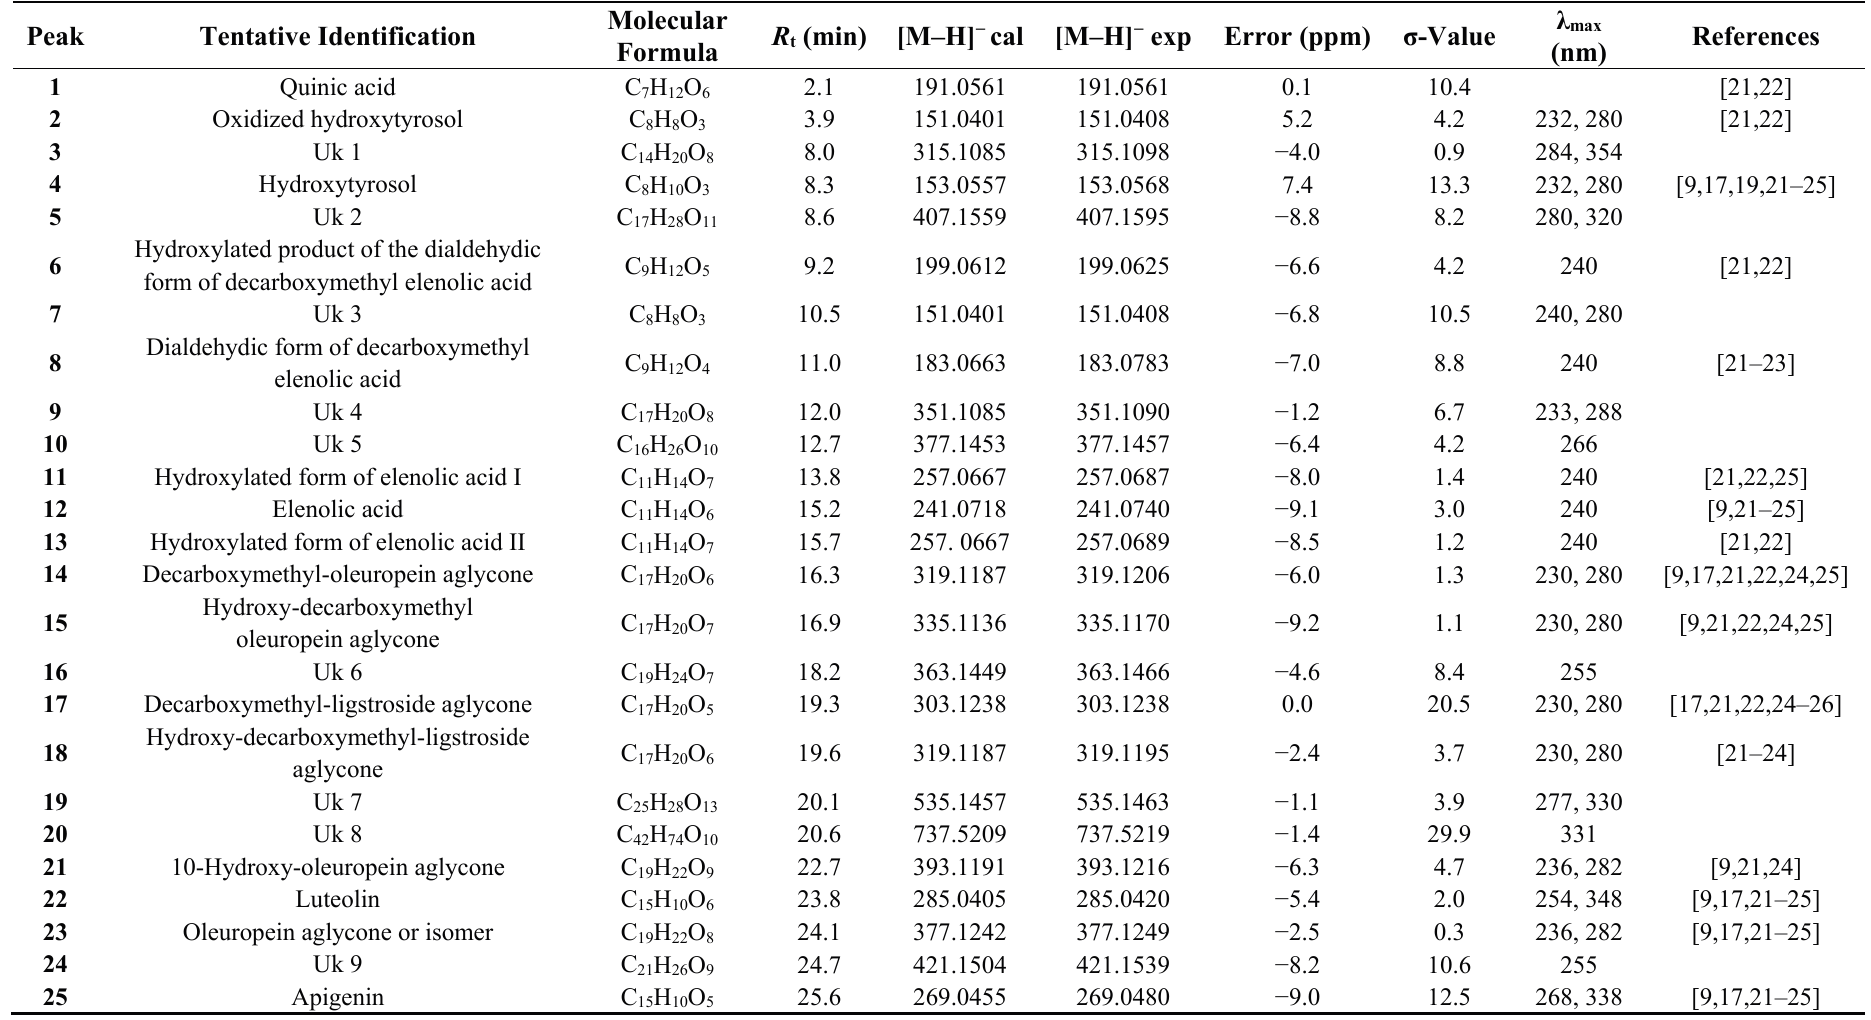
Table 2. Tentative identification of phenolic compounds and their derivatives in the filter cake PLE